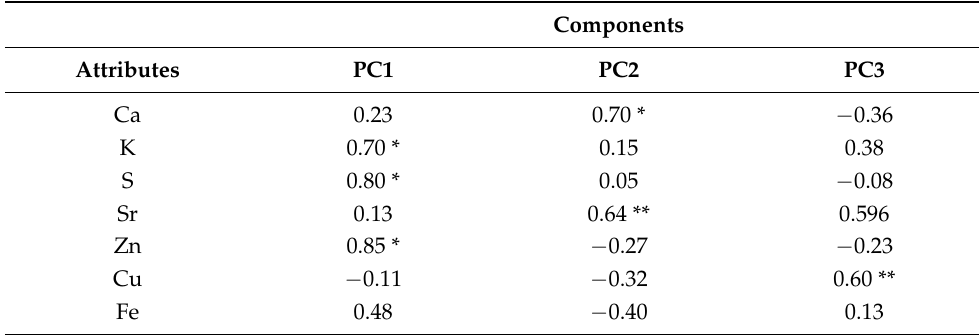
Table 4. Correlation coefficients between attributes and PC1, PC2, and